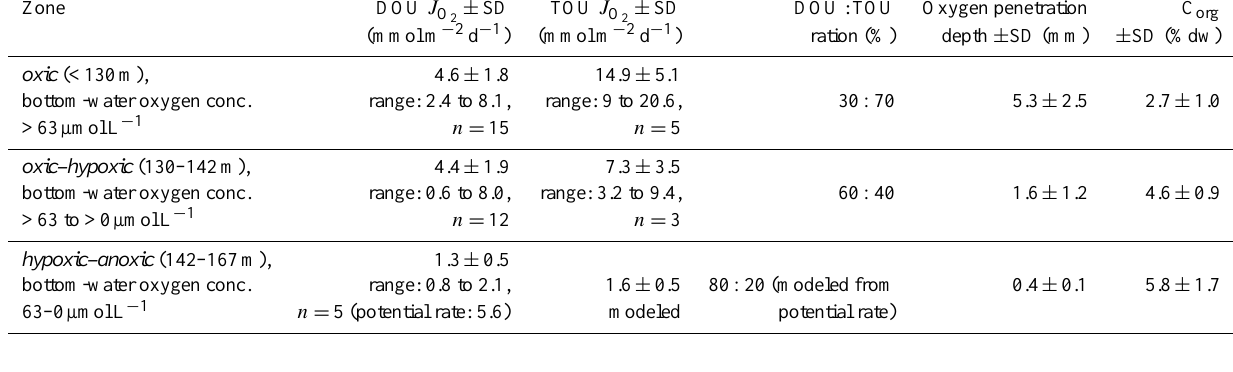
Table 2. Diffusive oxygen uptake (DOU) rates, total oxygen uptake (TOU) rates and oxygen penetration depth under different oxygen regimes at the outer western Crimean shelf. Chamber measurements in the hypoxic–anoxic zone represent potential rates, scaled to a bottom-water